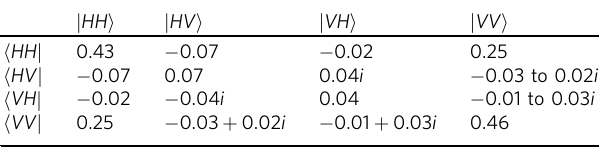
Table 2 The elements of the density matrix with